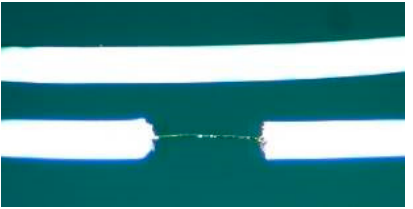
Figure 9. Appearance of a sample with one intact element conductor.